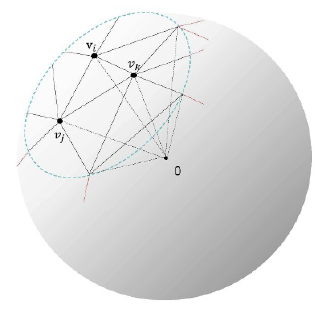
Figure 8. A general triangulation of a